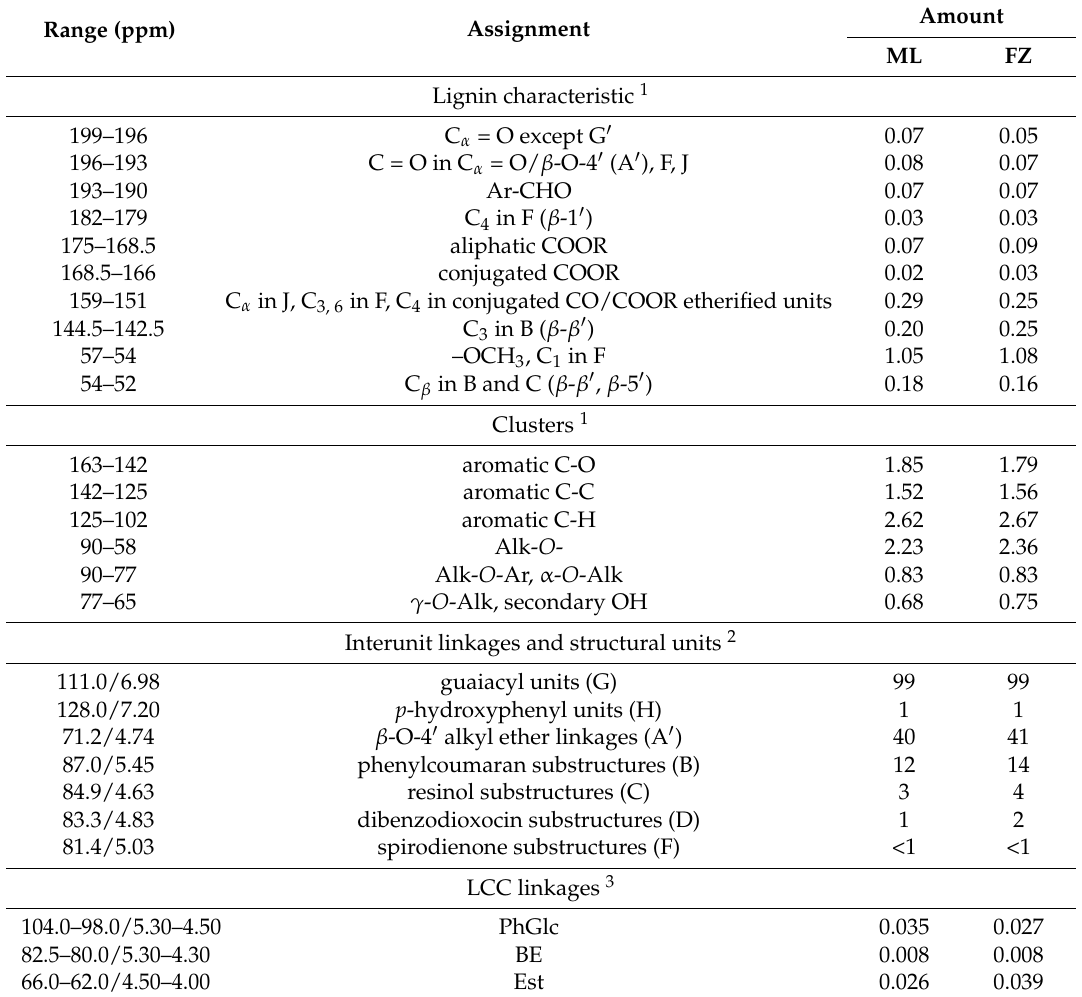
Table 4. Lignin and LCC linkage characteristics from the integration of quantitative 13 C and 2D HSQC NMR